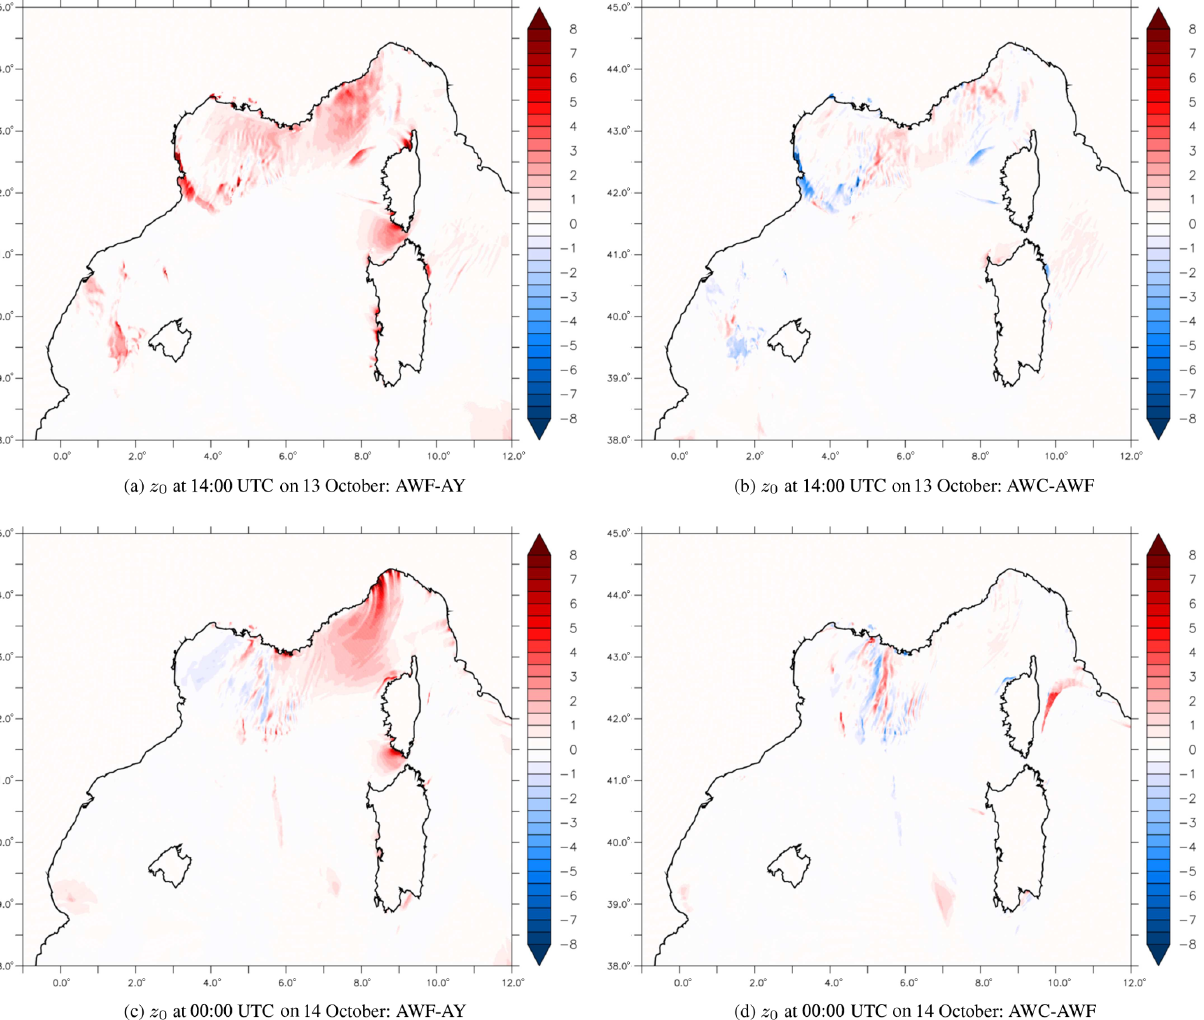
Figure 9. z 0 (10 − 3 m) differences at 14:00UTC on 13 October (a, b) and at 00:00UTC on 14 October (c, d) between AWF–AY (a, c) and AWC–AWF (b, d)